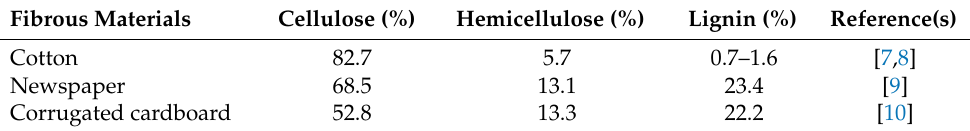
Table 1. Composition of some fibrous